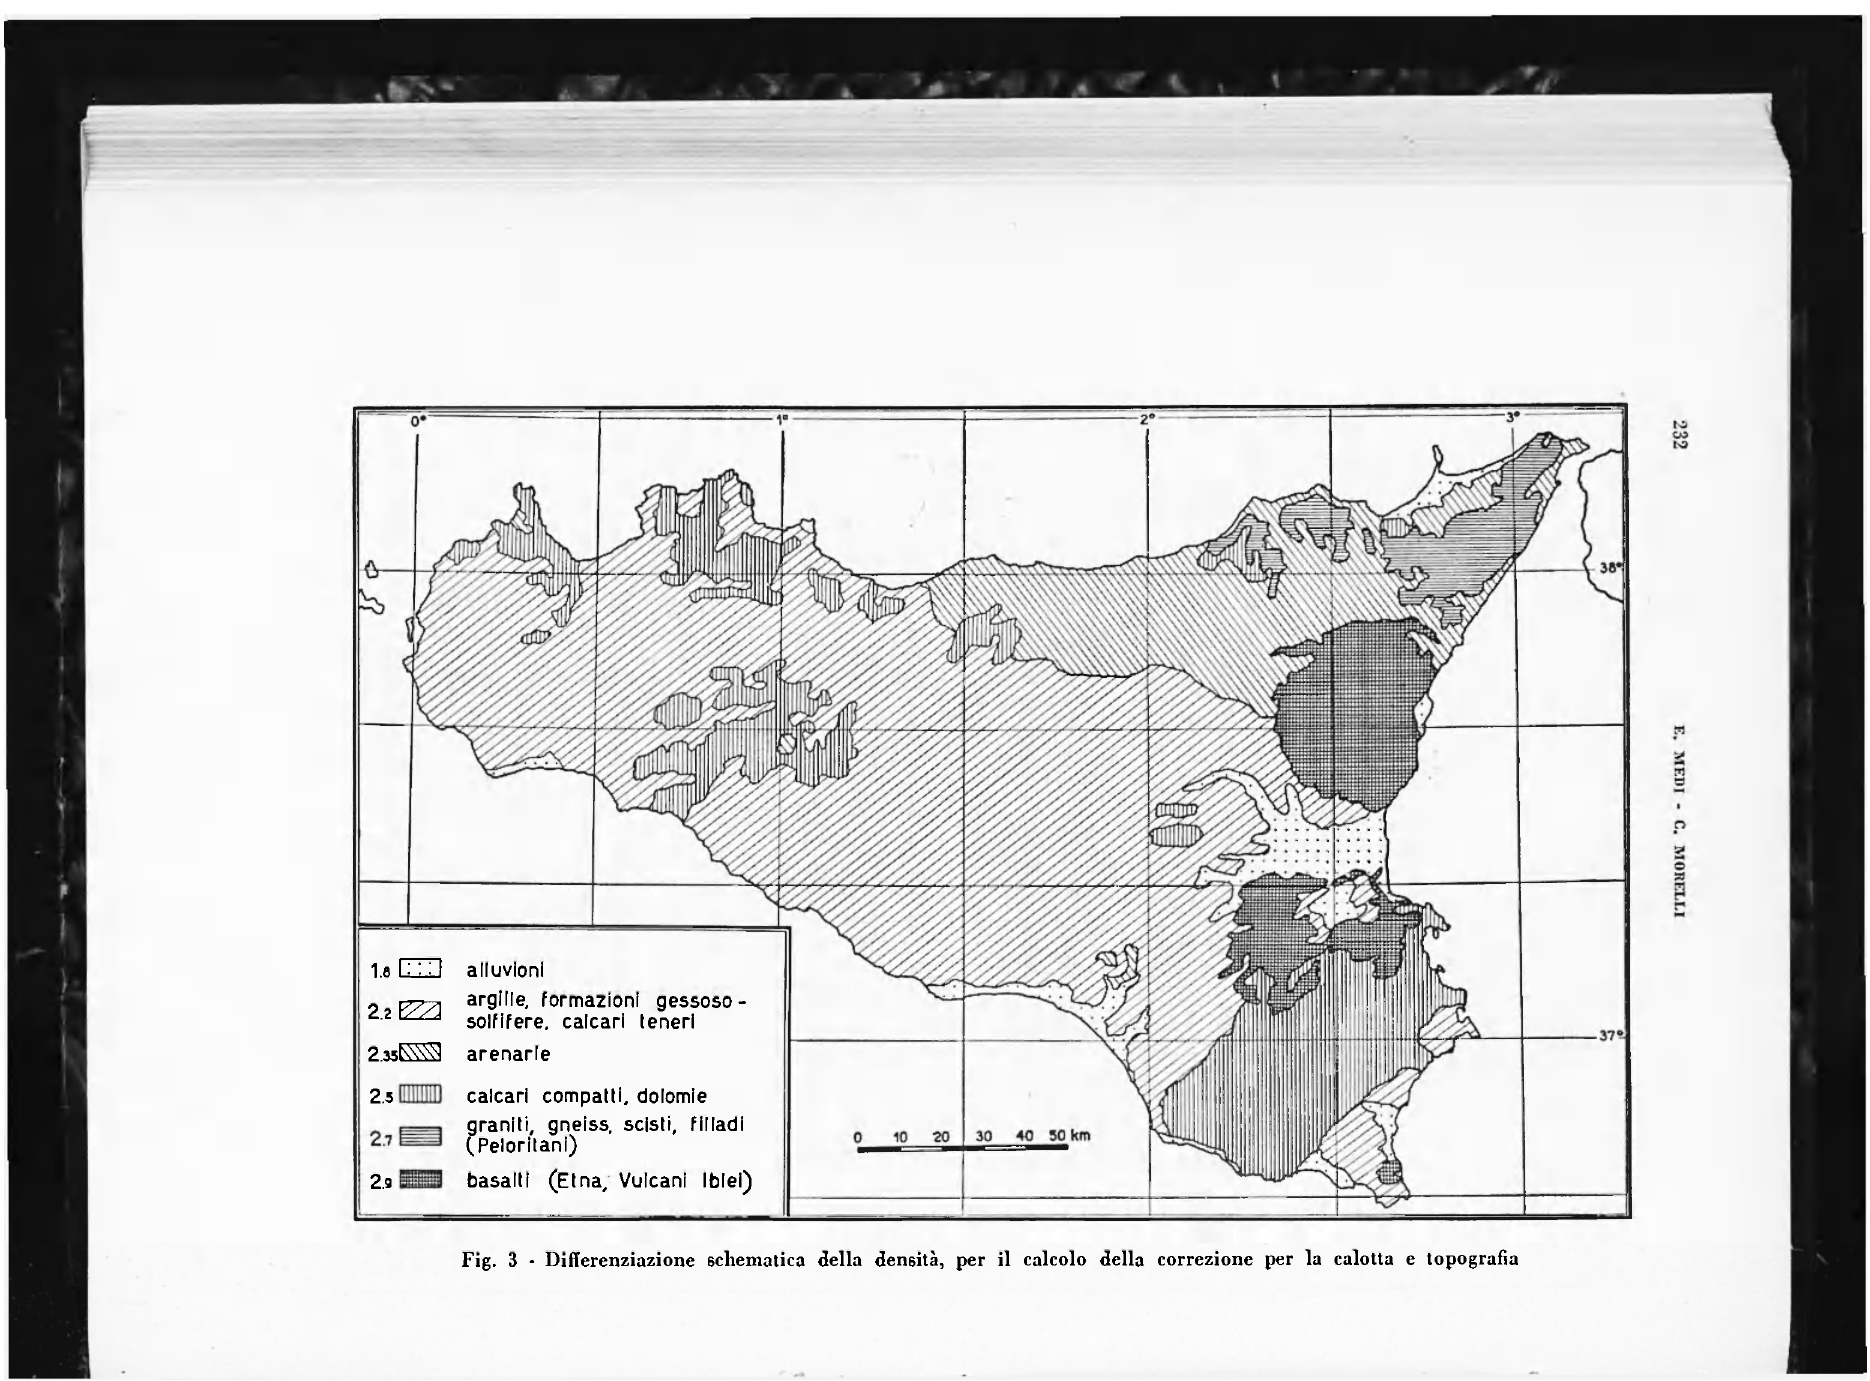
Fig. 3 - Differenziazione schematica della densità, per il calcolo della correzione per la calotta e